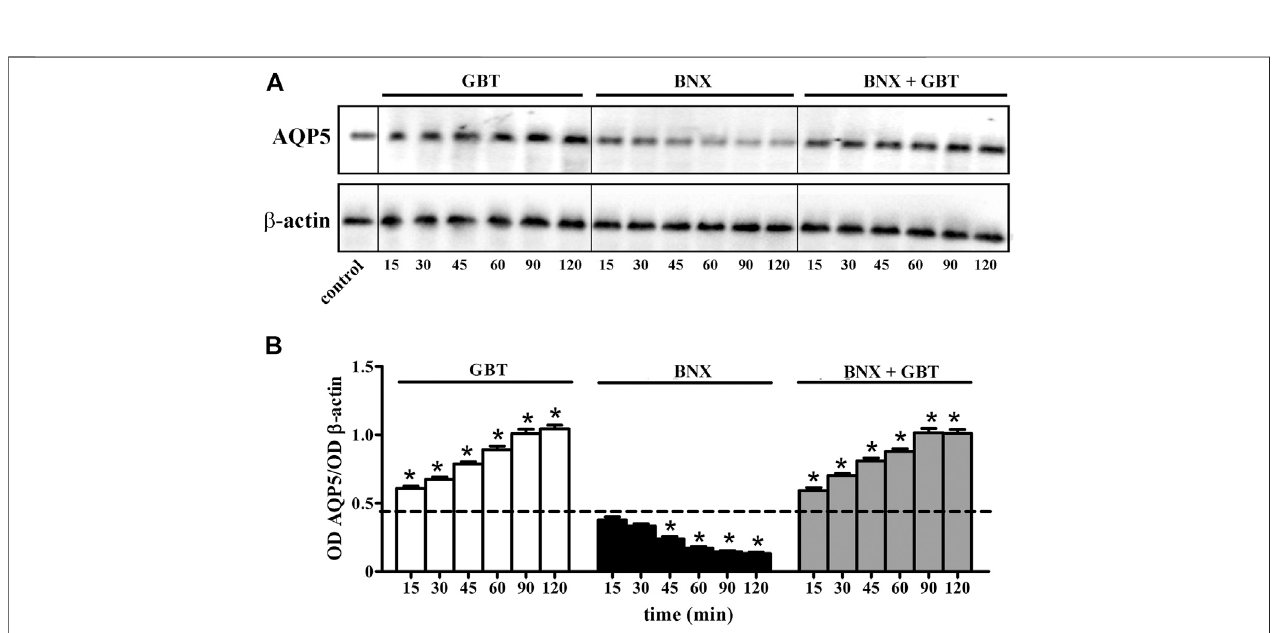
FIGURE 6 | Longitudinal evaluation of AQP5 levels in the lacrimal gland following 2% GBT, 0.4% BNX or GBT after BNX pretreatment. (A) Representative blots depicting levels of AQP5 as determined by Western blotting. (B) Densitometric analysis of AQP5 levels. The expression of AQP5 was relative to the loading control β -actin. Data are plotted as mean ± SEM. The dotted line indicates the basal value. Differences between groups were tested for statistical signi fi cance using one-way ANOVA with Tukey ’ s multiple comparison post-test. * p < 0.05 relative to basal ( n (cid:2) 6 lacrimal glands).